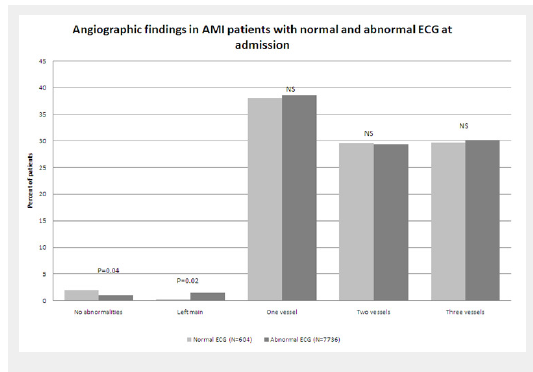
Delay from symptom onset to presentation in AMI patients according to the ECG on admission.